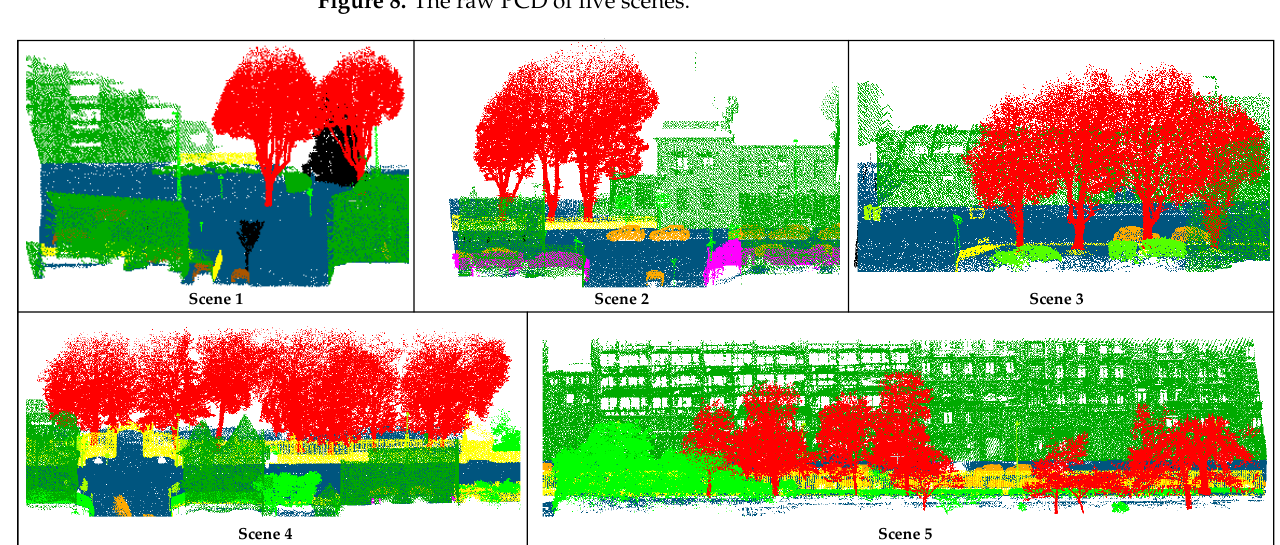
Figure 9. The semantic segmentation results of five scenes.